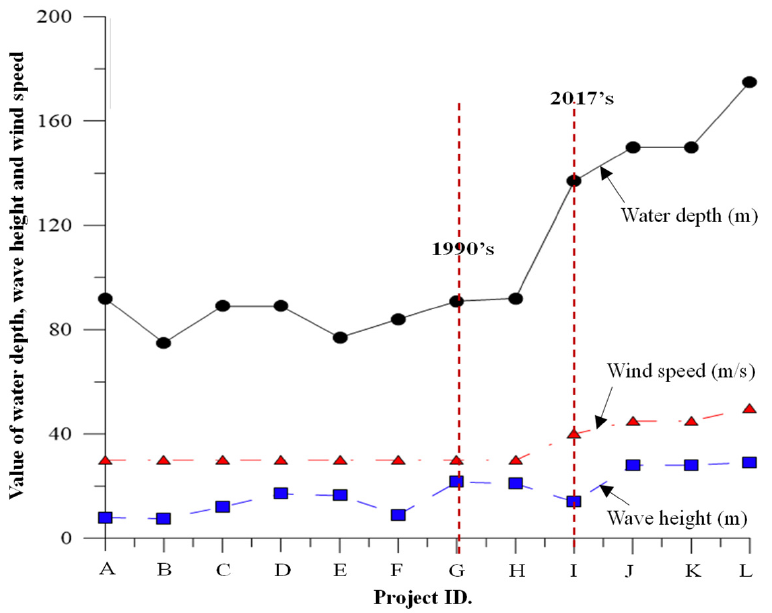
Figure 2. A comparison of the environmental parameters according to projects for jack-up rigs.